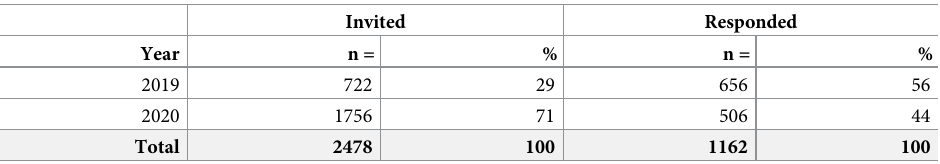
Table 2. Sample frame distribution by year of data